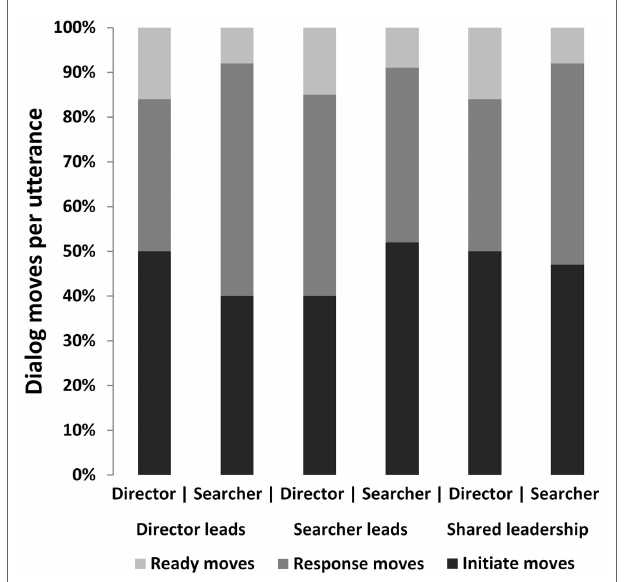
FigUre 7 | Distribution of dialog moves by speaker role for each coordination strategy